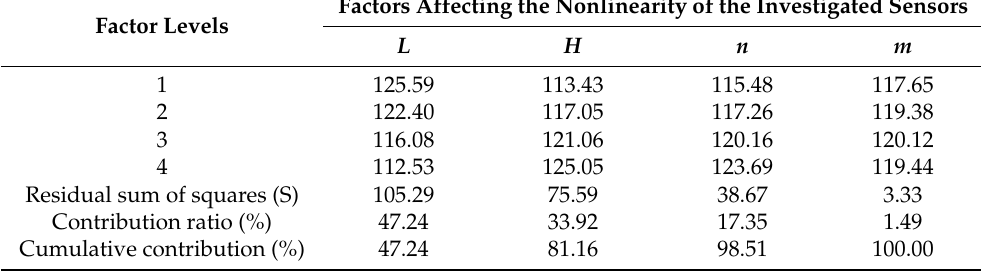
Table 5. The Pareto ANOVA table for nonlinearity. Table 4. The Pareto ANOVA table for sensitivity. Factor